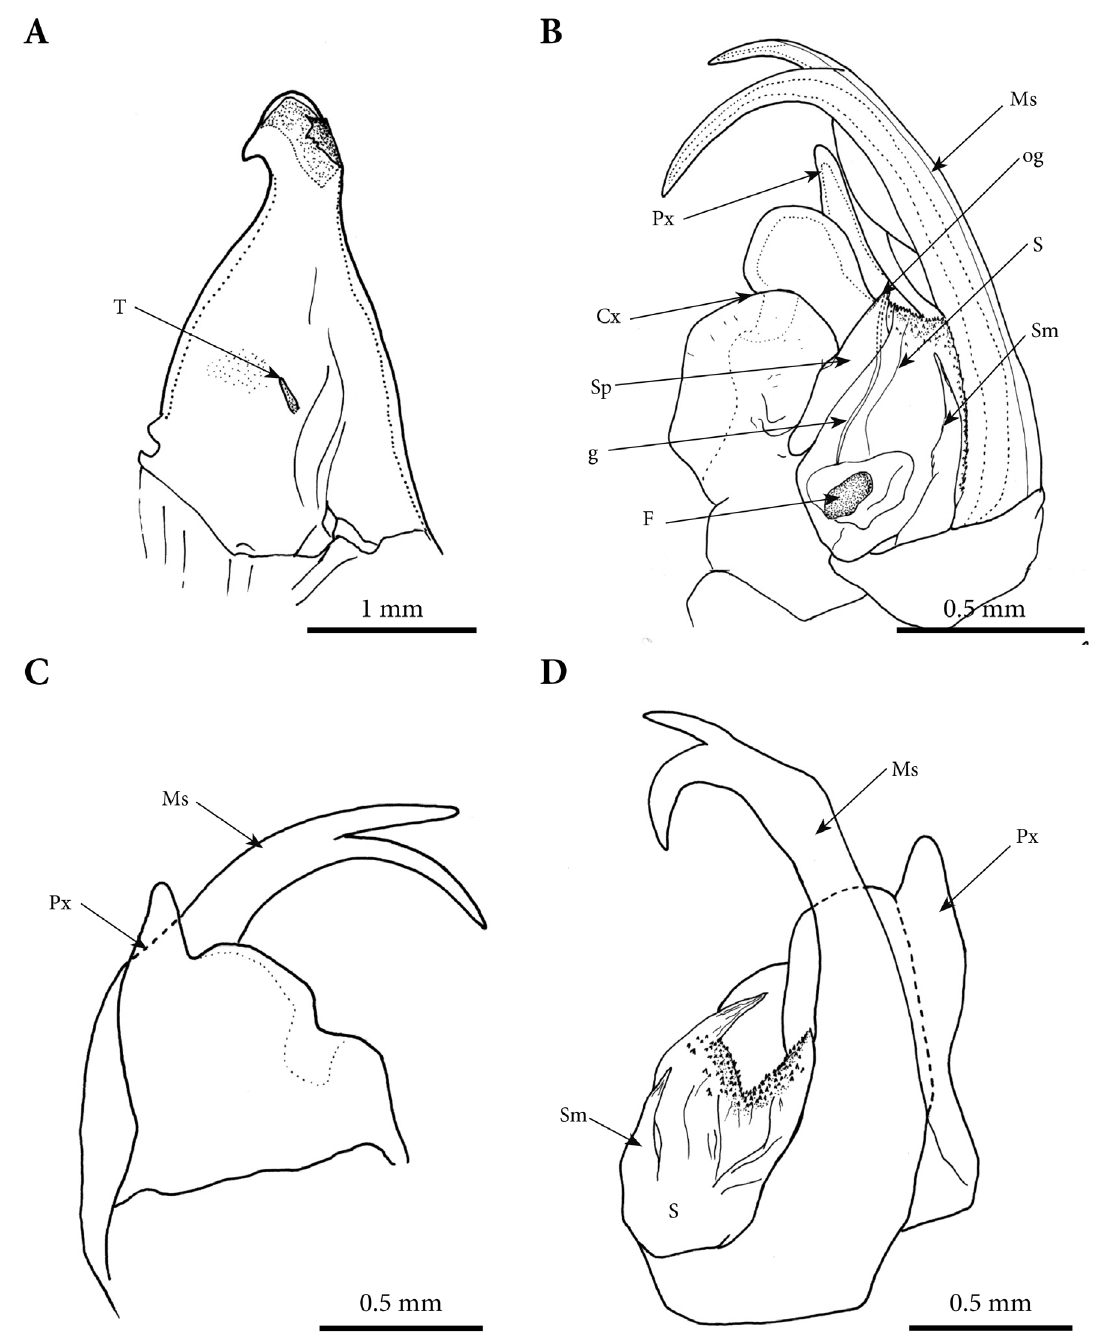
Fig. 8. Ommatoiulus camurus sp. nov. Holotype ♂, gonopods. A . Right promerite, posterior view. B–D . Right posterior gonopod: B . Mesal view. C . Posterior view. D . Lateral